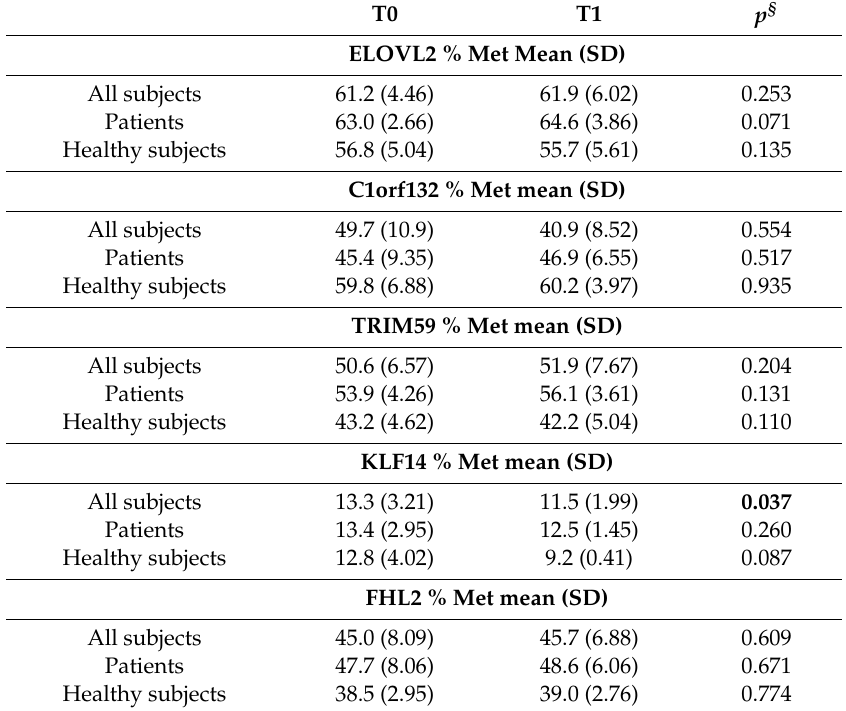
Table 3. Methylation levels (% met) of five selected markers at enrolment T0 and after 60 days of relaxing practices T1.